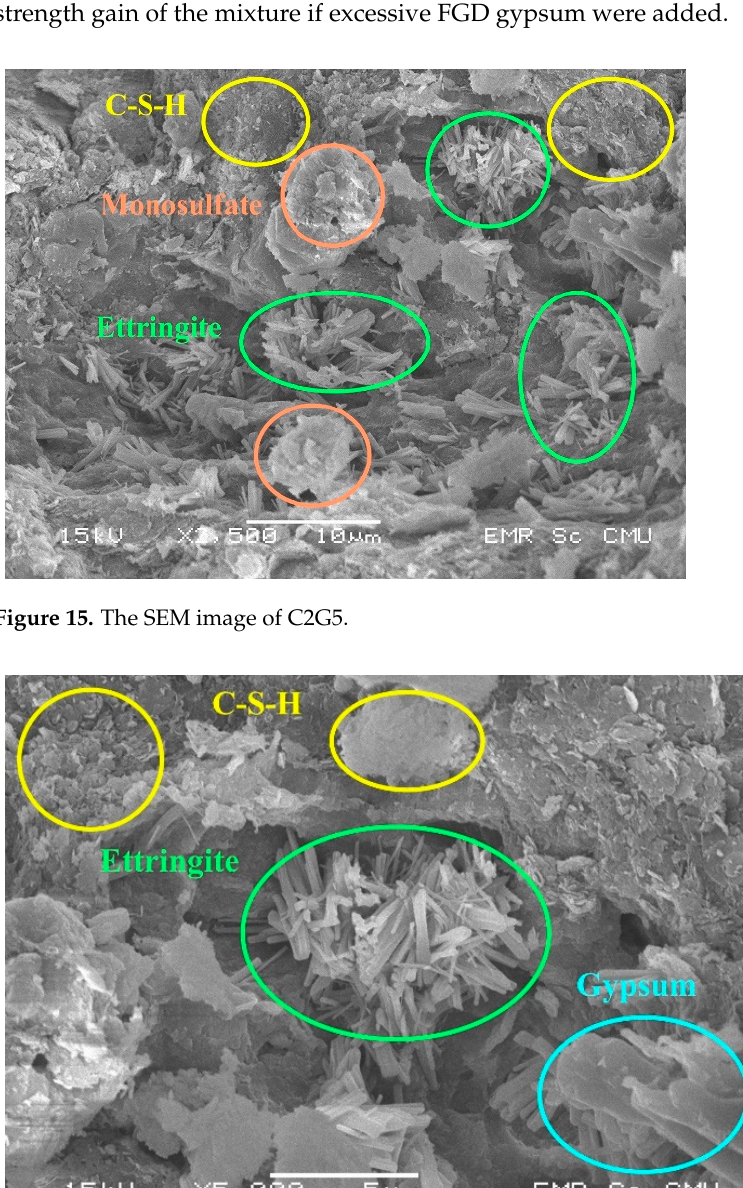
Figure 15. The SEM image of C2G5.